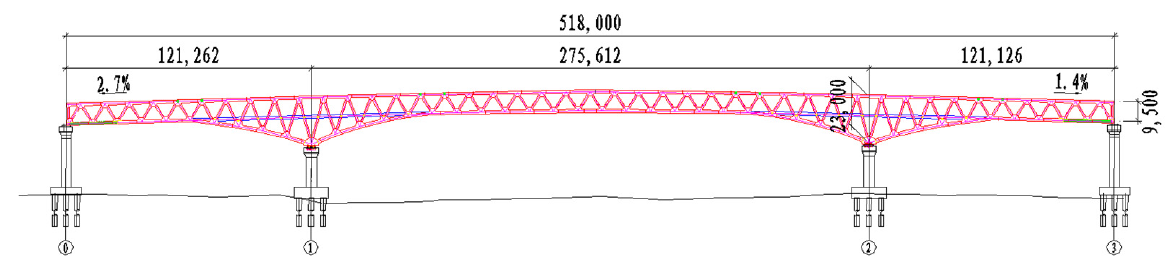
Figure 1. The layout of main span (Unit: mm).